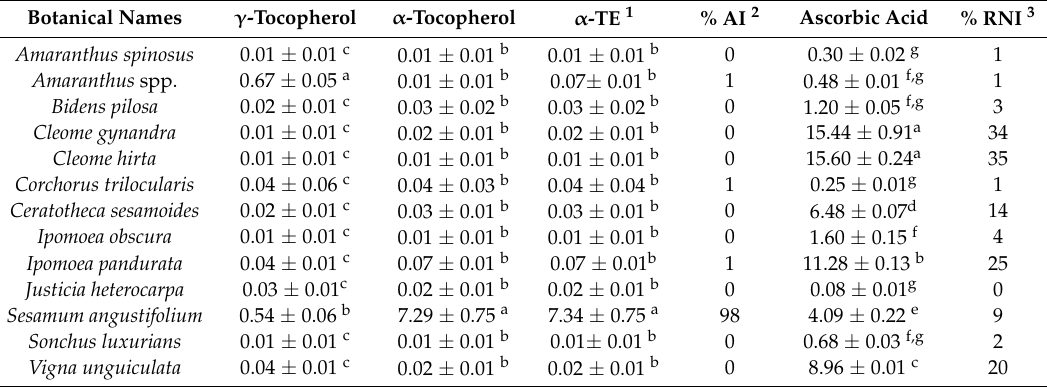
Table 3. Tocopherols and ascorbic acid contents (mg/100 g fresh weight) in ILVs